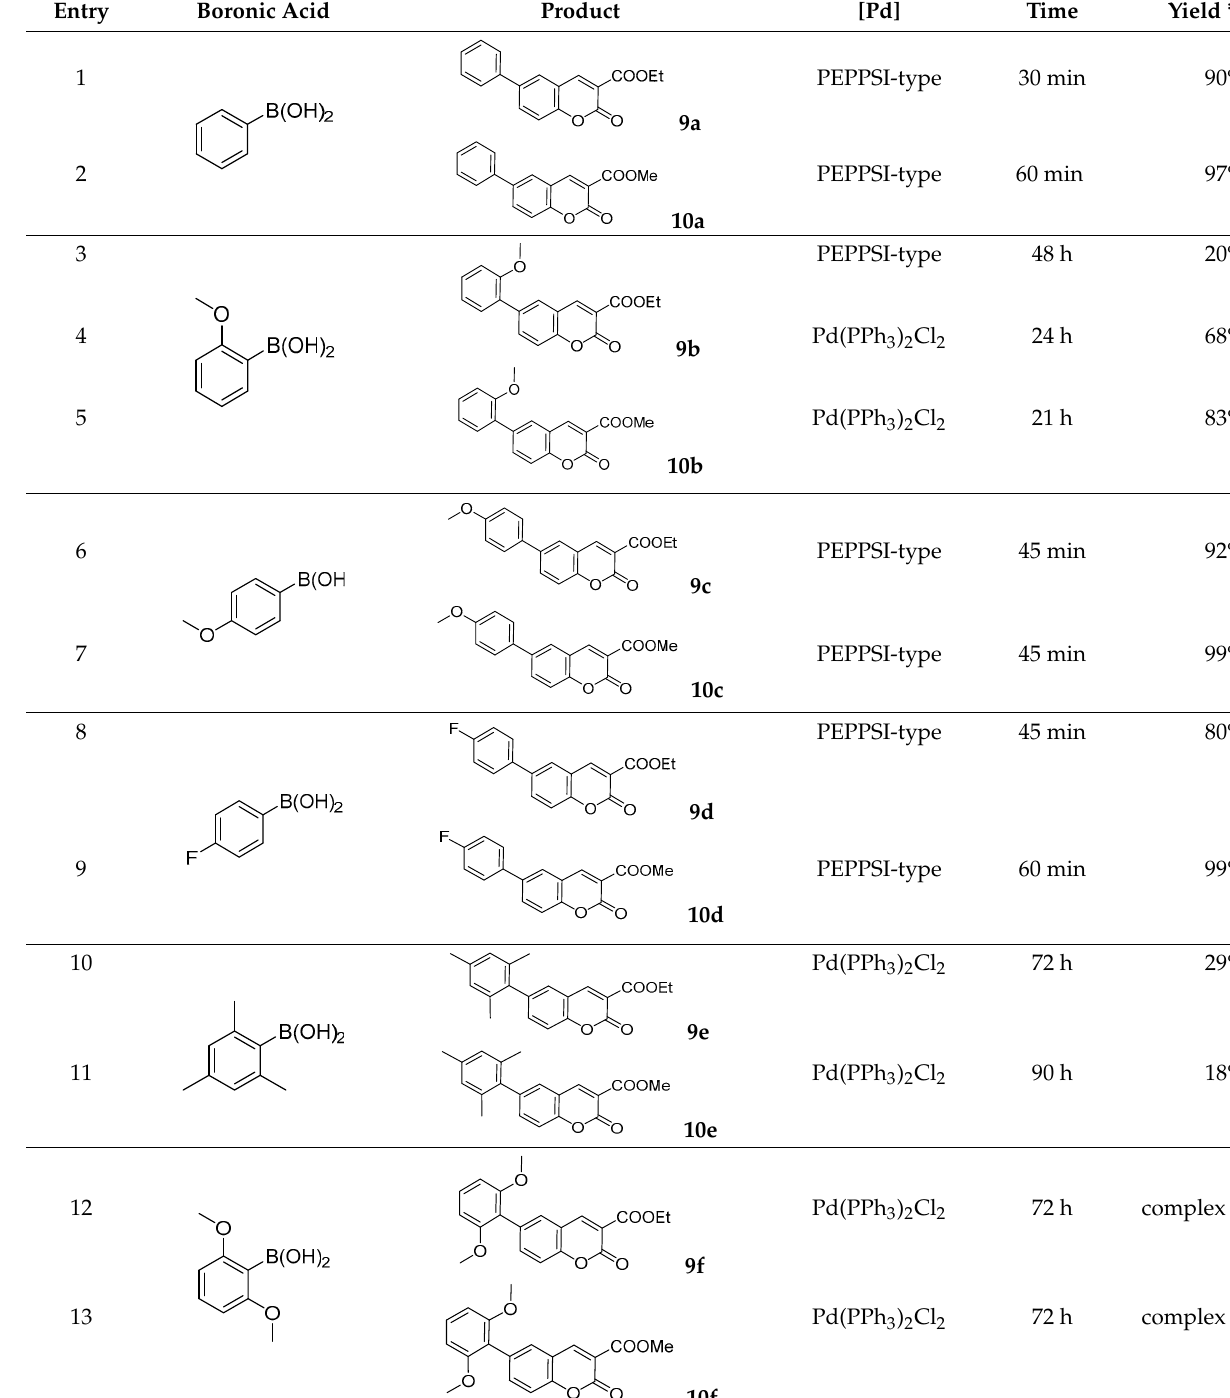
Table 4. Parameters, reagents, and products of palladium-catalyzed arylation of 6-bromocoumarin-3-carboxylates 8a,b .